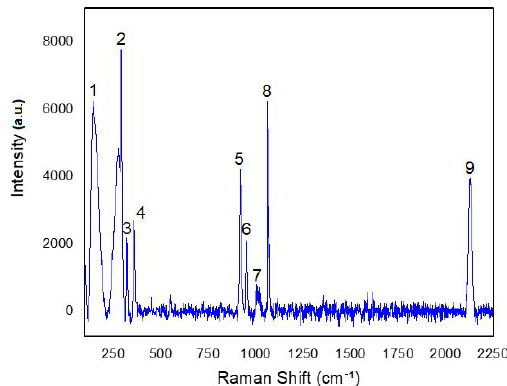
Figure 5. Raman Spectrum of Macusanite inclusion.